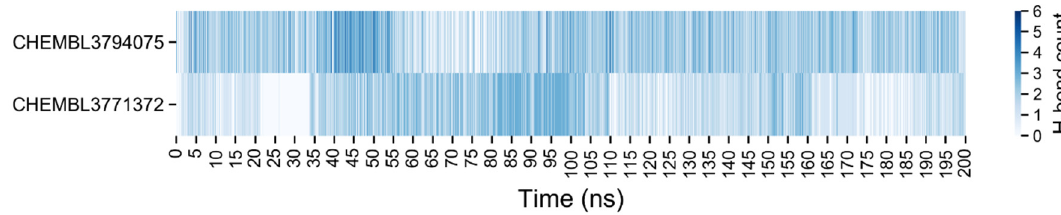
Figure 17. Number of hydrogen bonds between the EZH2 and the ligands, the top from the CHEMBL3771372 and the bottom from the CHEMBL3794075. A detailed plot is shown in Supporting Figures S8 and S9.